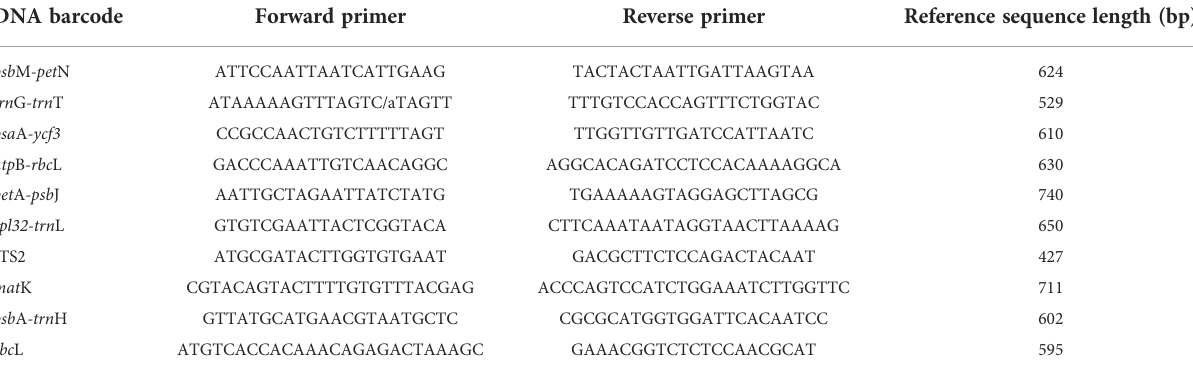
TABLE 1 Universal primer sequences and polymerase chain reaction conditions for 10 DNA barcode regions. DNA